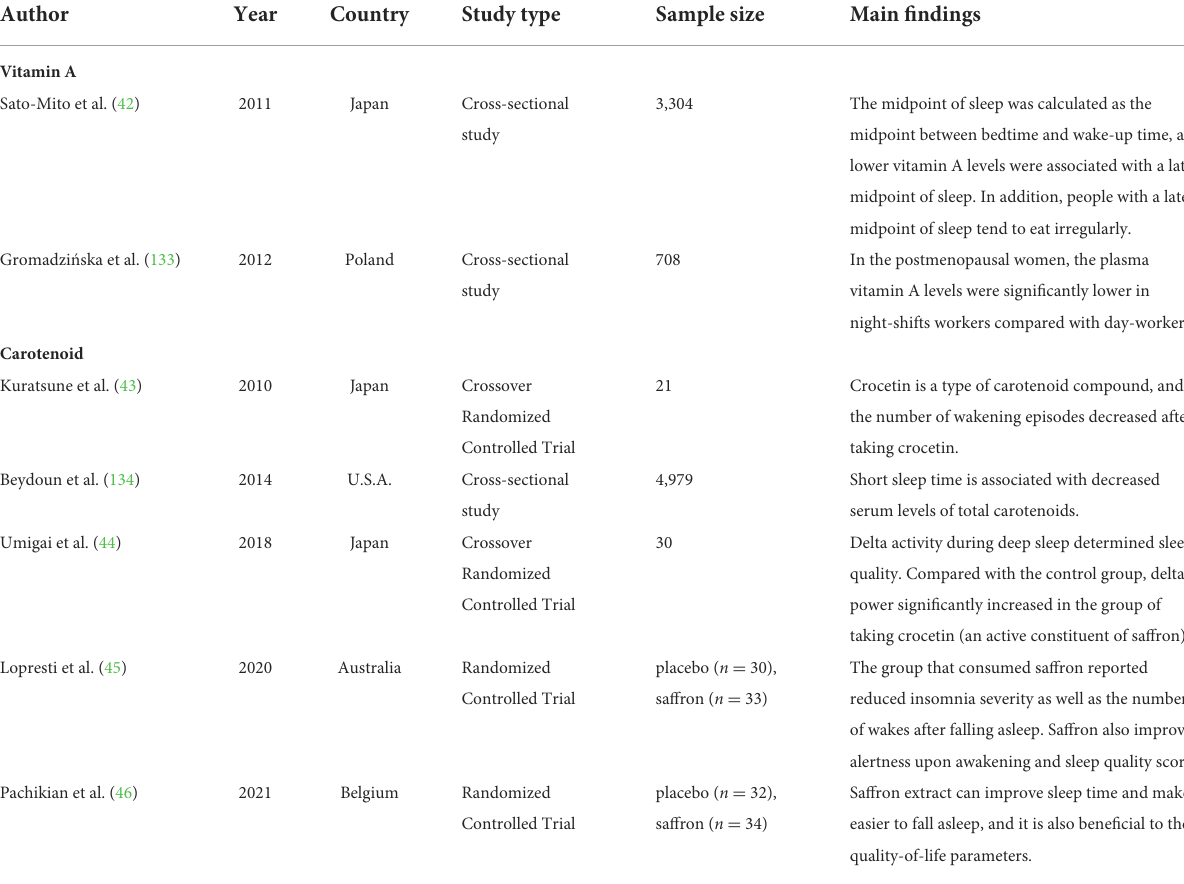
TABLE 2 Findings of epidemiological studies related to the associations of vitamin A or carotenoid with biological